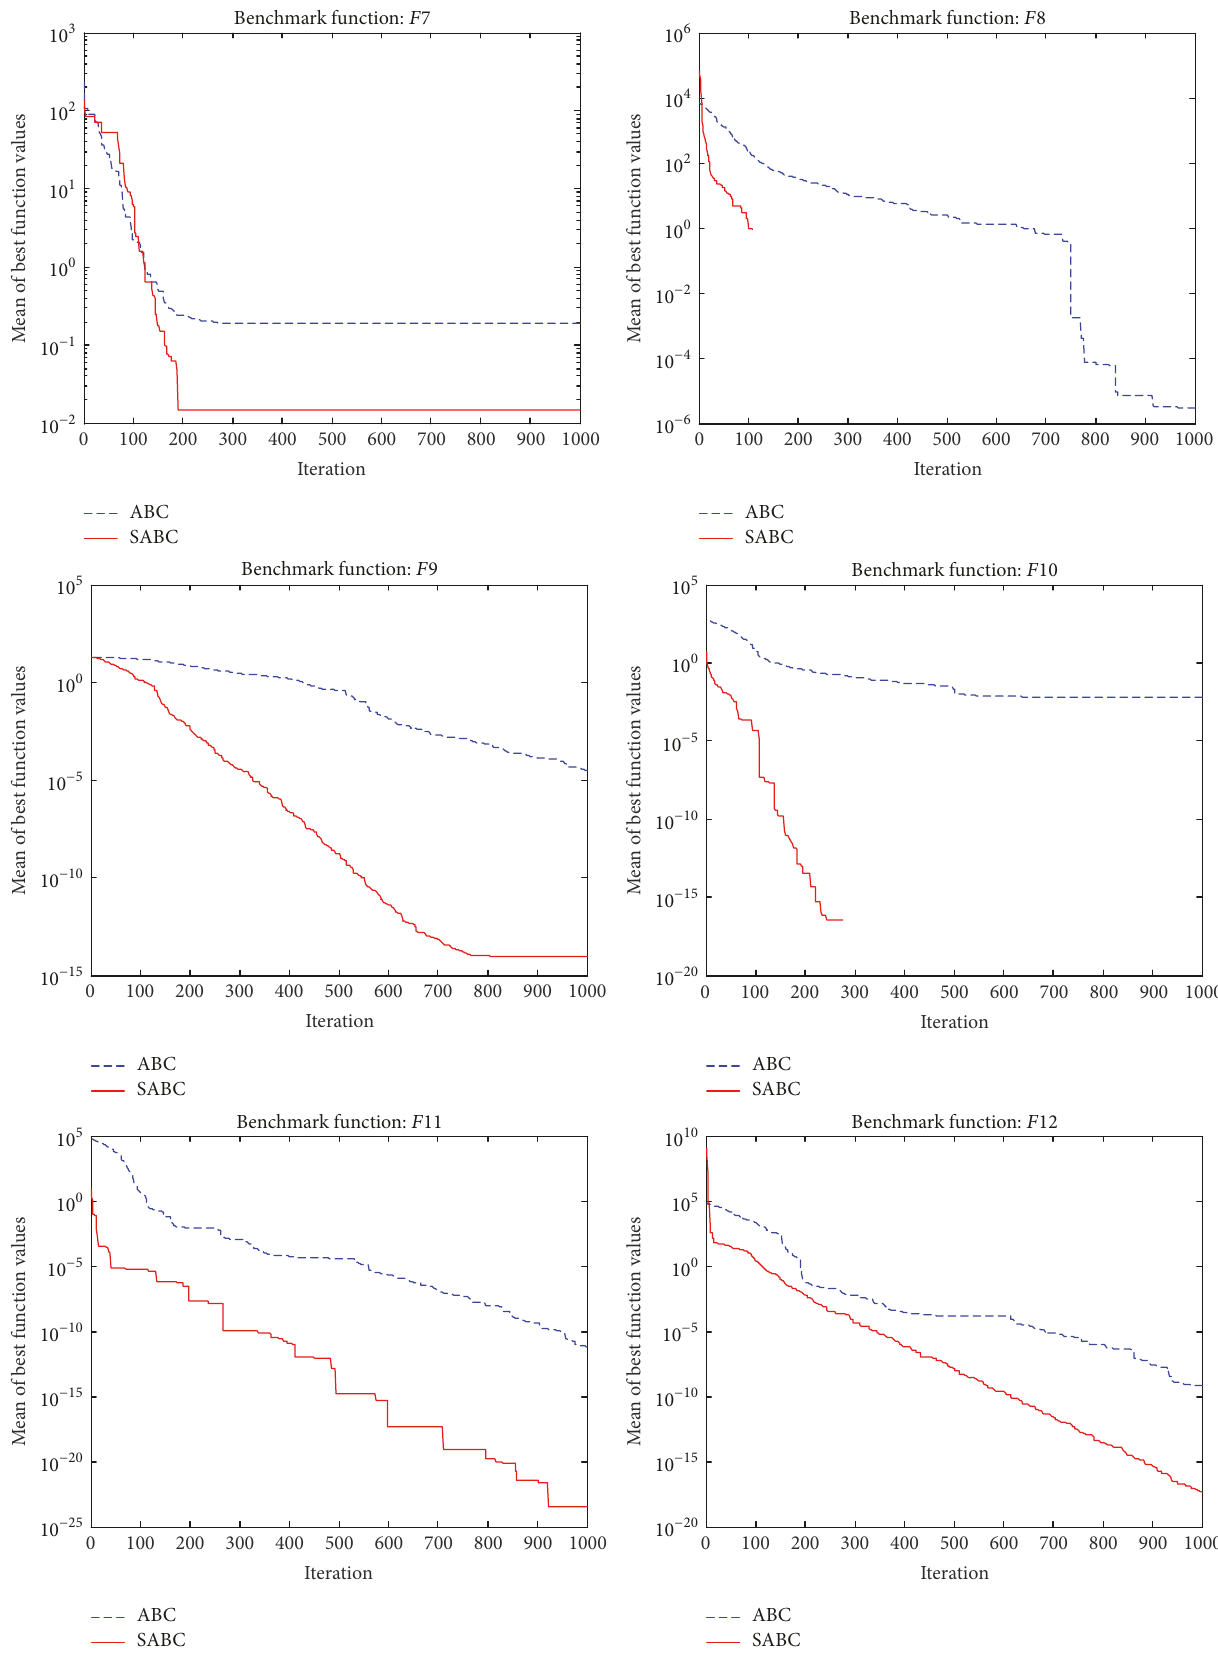
Figure 3: Convergence curve of SABC and basic ABC for twelve functions ( 𝐷 = 30